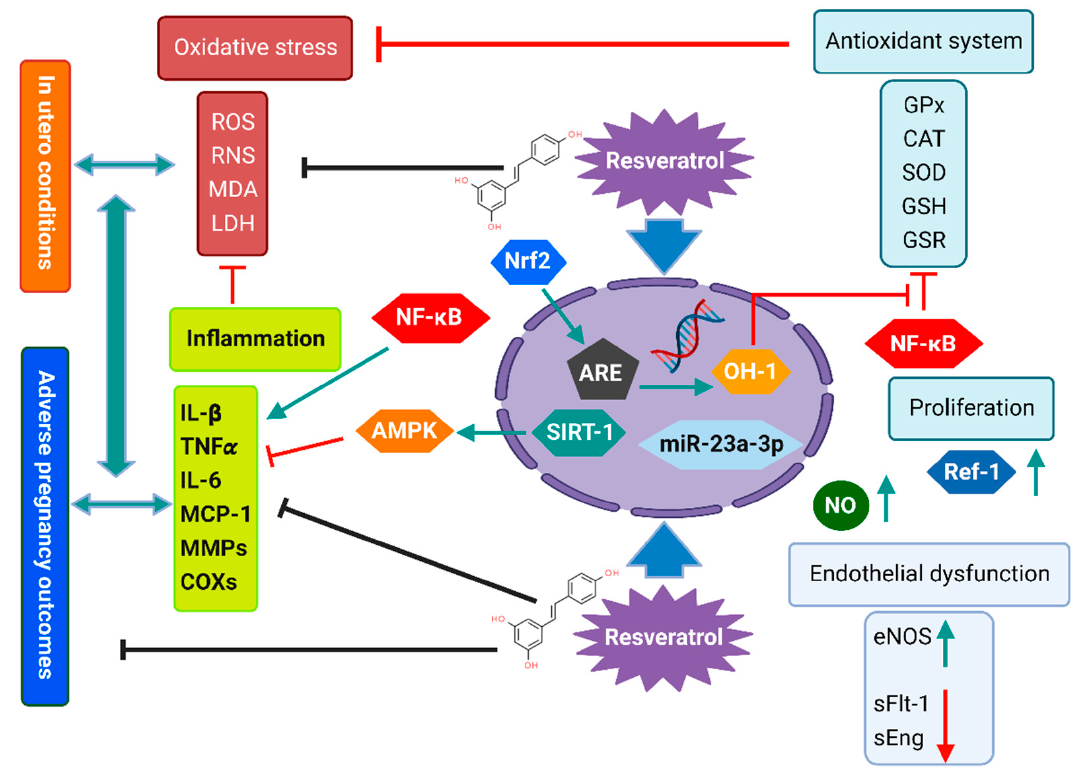
Figure 1. Potential molecular mechanisms underpinning the effects of resveratrol intake in mothers and their offspring in different models.